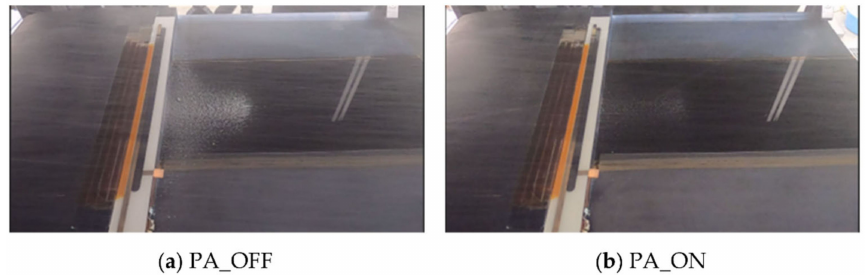
Figure 25. Snow accumulation test [120 s] (2021).